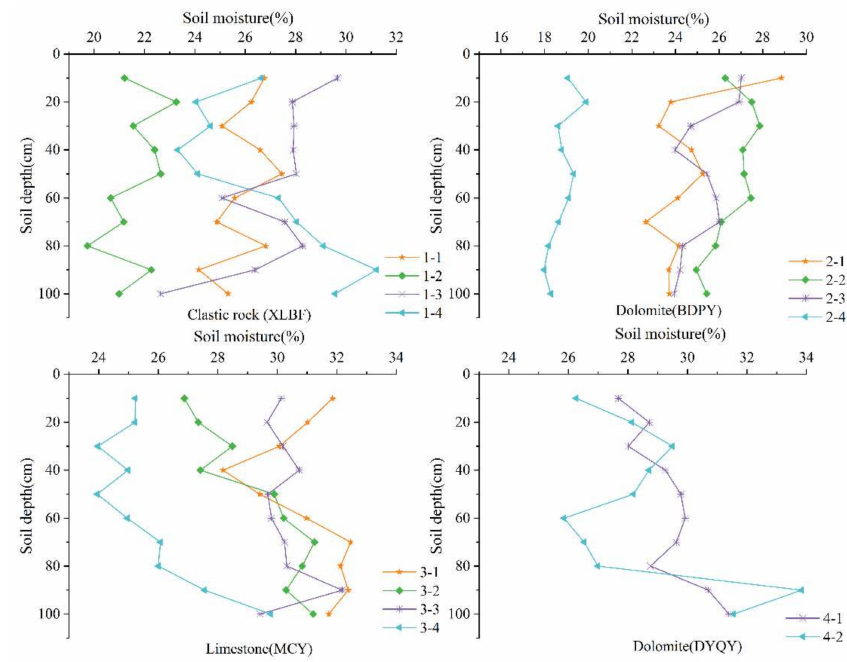
Figure 4. Relationship between soil profile moisture contents and depth (1-1 tree forest, 1-2 tree and shrub forest, 1-3 scrub, 1-4 bare land; 2-1 tree forest, 2-2 tree and shrub forest, 2-3 tree forest, 2-4 bare land; 3-1 tree forest, 3-2 tree and shrub forest, 3-3 scrub forest, 3-4 bare land, 4-1 scrub forest, 4-2 bare